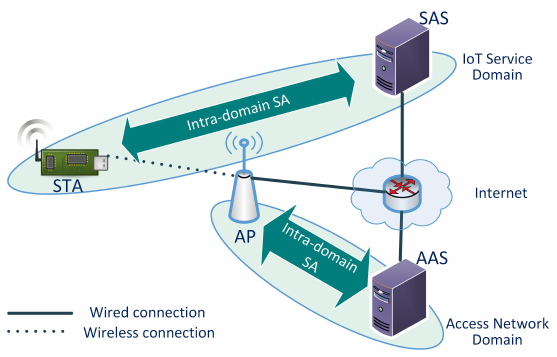
Figure 3. IoT Authentication